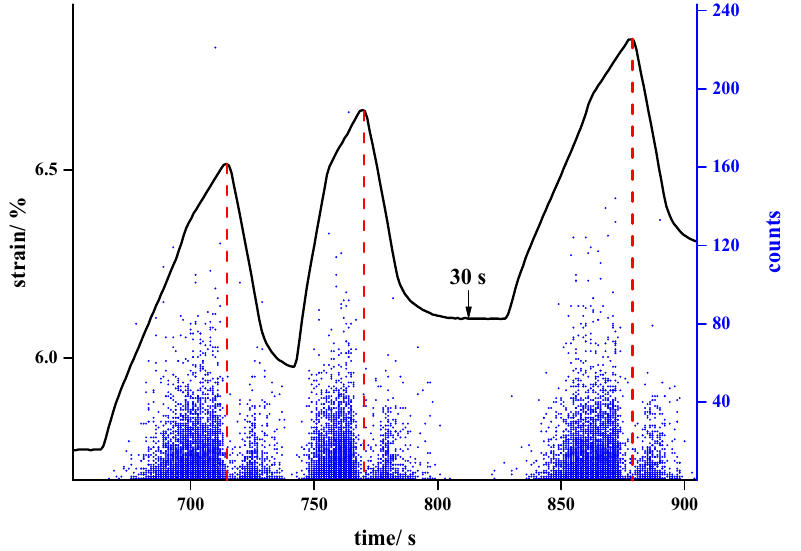
Figure 10. Partial enlarged detail of Figure 7a for test carried out with a 30 s fatigue interval.